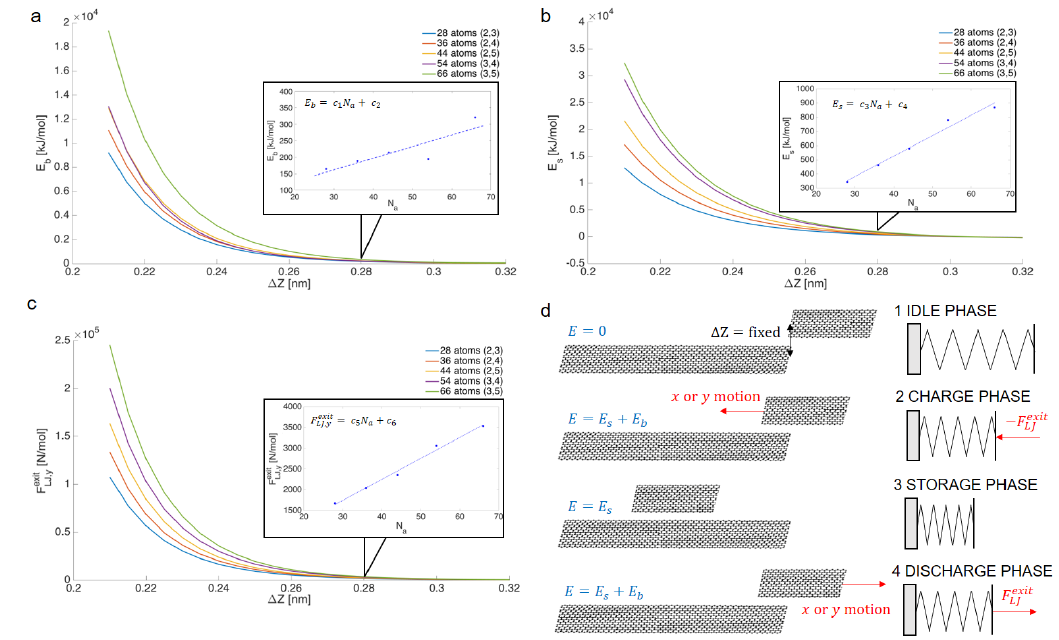
Figure 6. ( a ) Energy barrier, E b ; ( b ) storable energy, E s ; and ( c ) exit force, F exit for pairs of sliding LJ , y graphene sheets at a different normal distance ( ∆ Z ). Various sizes of the sliding sheet are also considered (colored lines). Note that the considered direction of sliding is along the y axis. In the insets, the trend of E b , E s , and F exit at fixed ∆ Z = 0.28 nm and with different numbers of atoms of the sliding LJ , y sheet ( N a ) is represented. The coefficients of the linear fittings in the insets are equal to c 1 = 3.5 kJ/mol, c 2 = 56.1 kJ/mol, c 3 = 14.4 kJ/mol, c 4 = − 50.5 kJ/mol, c 5 = 50.5 N/mol, and c 6 = 232.8 N/mol; ( d ) Conceptual scheme of a nano-spring made of two sliding graphene